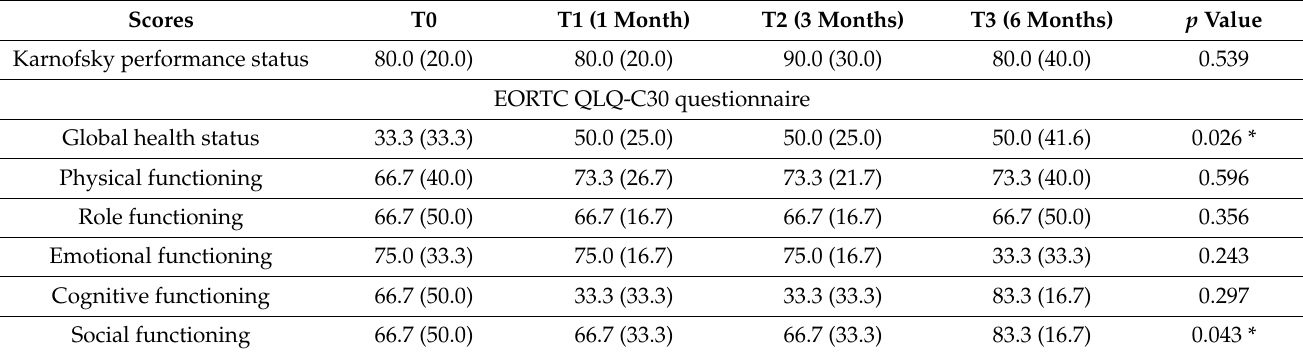
Figure 1. Pre- and post-operative lesions in two patients: ( a ) T2N0M0 squamous cell carcinoma of preauricular skin at T0; ( b ) partial response of preauricolar skin cancer at T3 with bleeding control; ( c ) rT3N0 squamous cell carcinoma of the tongue at T0; ( d ) partial response of tongue cancer at T3. Table 3. Karnofsky Performance status, Numeric Rating Scale (NRS) for pain, EORTC QLQ-C30 and H&N35 questionnaires results (median and interquartile